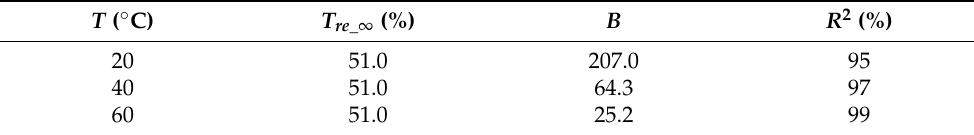
Table 15. Determined values of T re _ ∞ and τ (G2).